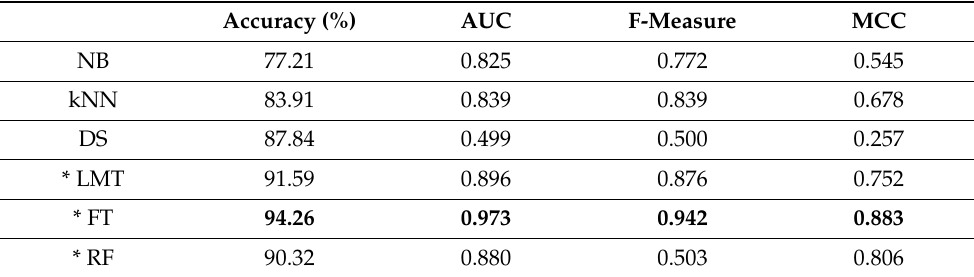
Table 6. The CCP performance of DF models and ML classifiers on Balanced (SMOTE) Dataset 2.